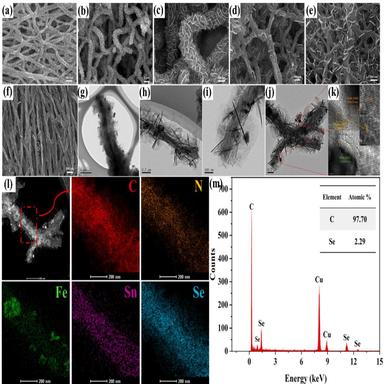
FE-SEM images of FeSe/SCNFs (a), FeSnSe/SCNFs-1 (b-c), FeSnSe/SCNFs-2 (d), FeSnSe/SCNFs-3 (e) and SnSe/SCNFs (f); TEM images of FeSnSe/SCNFs-1 (gj), HRTEM images (k), HAADF images and corresponding EDS elemental mapping images (l); EDS energy spectra of nanosheets on FeSnSe/SCNFs-1 fibers (m).